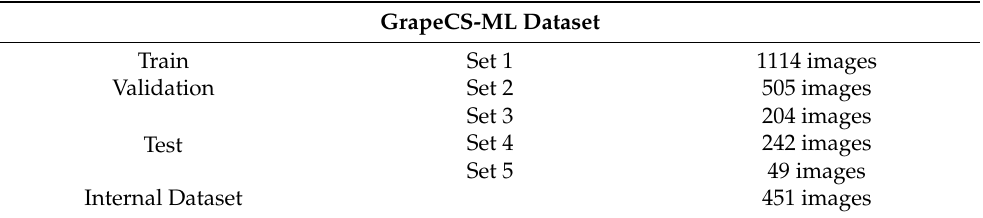
Table 2. Number of images contained in the GrapeCS-ML Dataset and in the internal